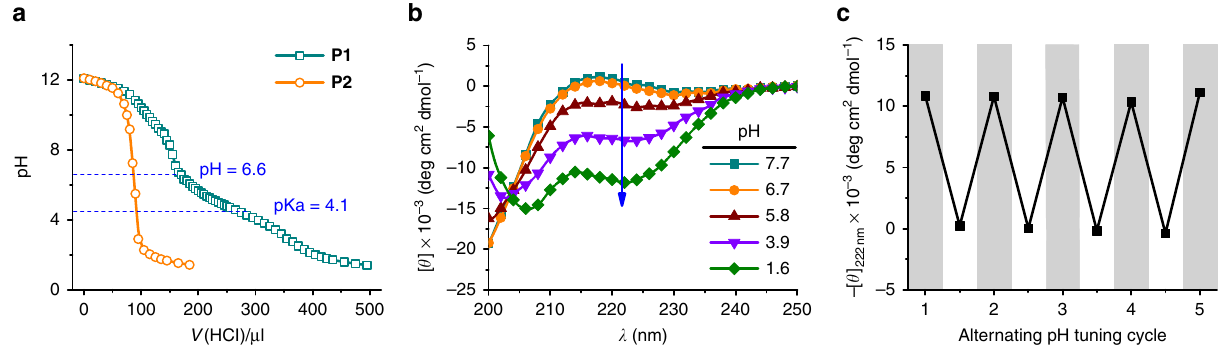
Fig. 3 Coil-to-helix transition induced by protonation of side-chain 1,2,3-triazole. a The pH titration curve of P1 with side-chain triazoles and P2 without side-chain triazoles. b CD spectra of P1 upon stepwise addition of concentrated HCl. c The mean residue molar ellipticity of P1 at 222 nm ( − [ θ ] 222nm ) after alternating addition of HCl and NaOH over fi ve cycles. At pH ~ 2.8 ( light grey background ), P1 adopts an α -helical conformation with a positive − [ θ ]